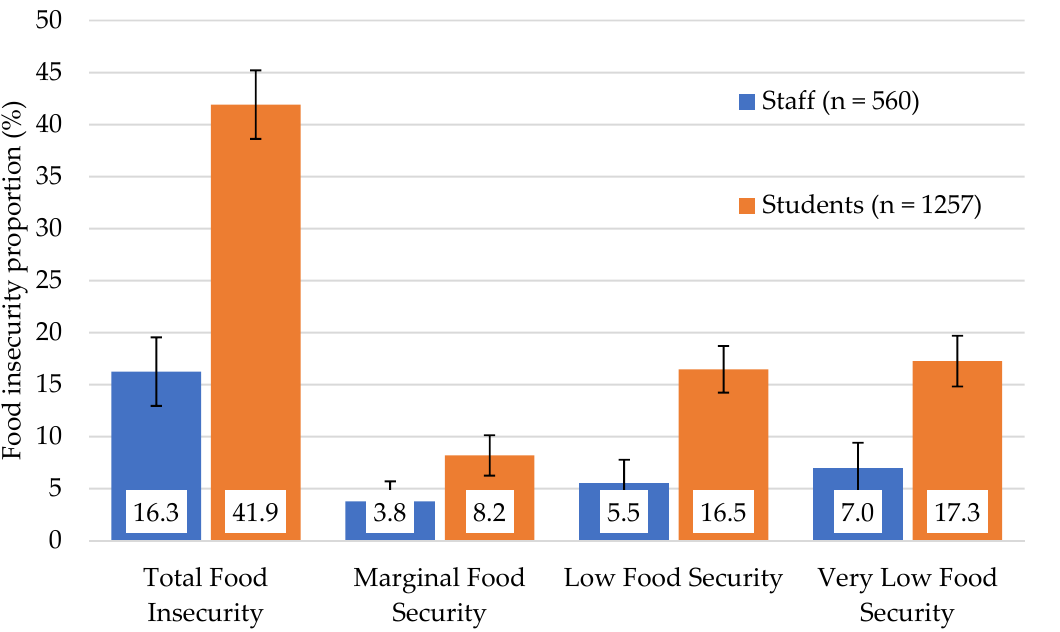
Figure 1. Student ( n = 1257) and Staff ( n = 560) Food Security Status according to the six-item HFSSM (error bars represent 95% Confidence Intervals).